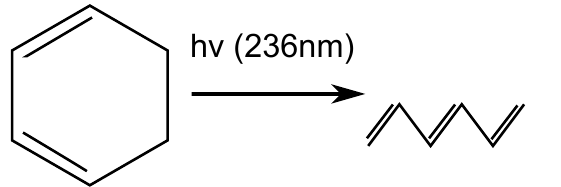
Figure 1. Change in molecular structure of 1,3-cyclohexadiene dimerisation to 1,3,5-hexatriene by electrocyclic